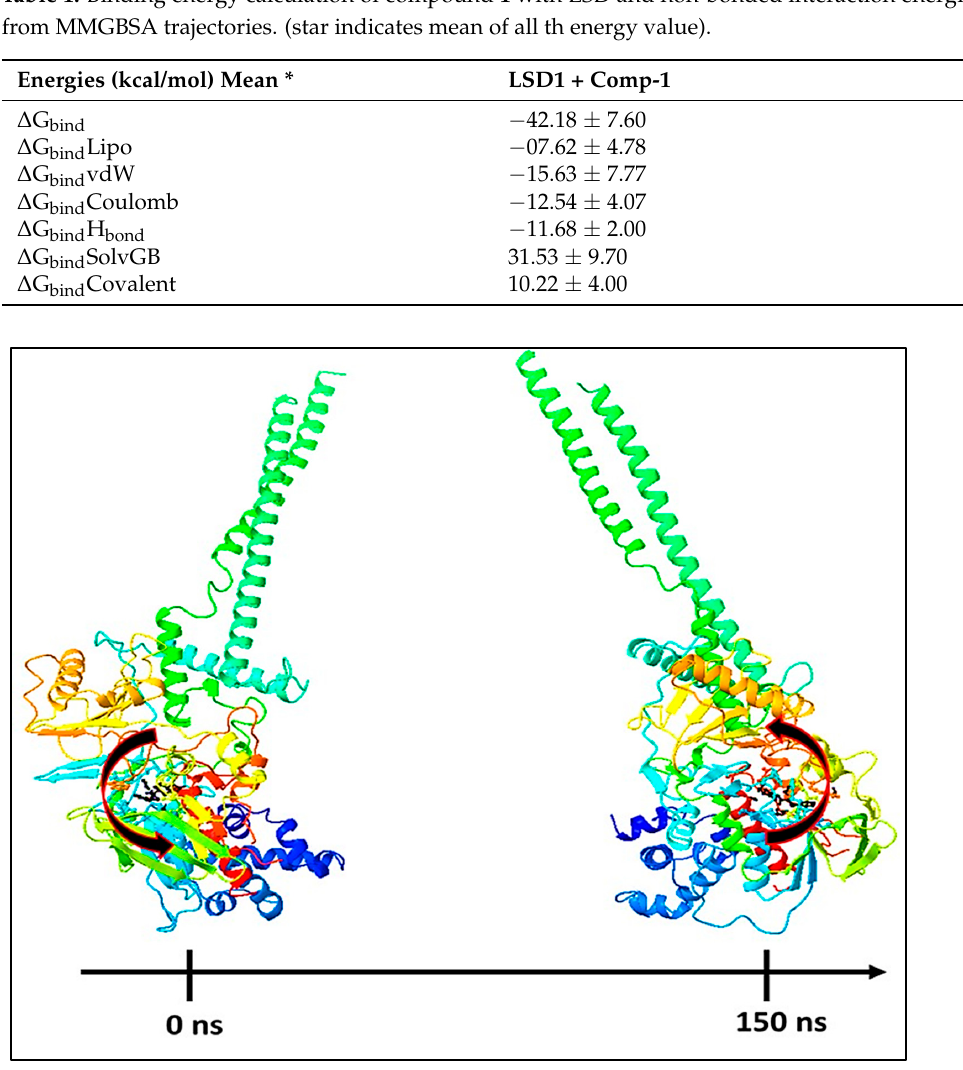
Figure 24. MMGBSA trajectory (0 ns, before simulation and 150 ns, after simulation) exhibited conformational changes of compound 1 upon binding with the proteins, LSD, the arrows indicating the overall positional variation (movement and pose) of compound 1 at the binding site cavity.